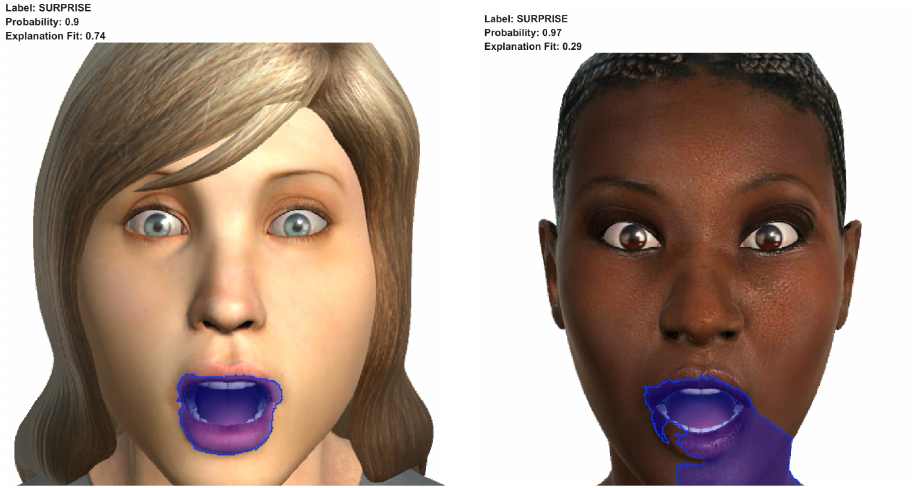
Figure 7. Results of applying LIME to the images of surprise correctly labelled as the emotion of